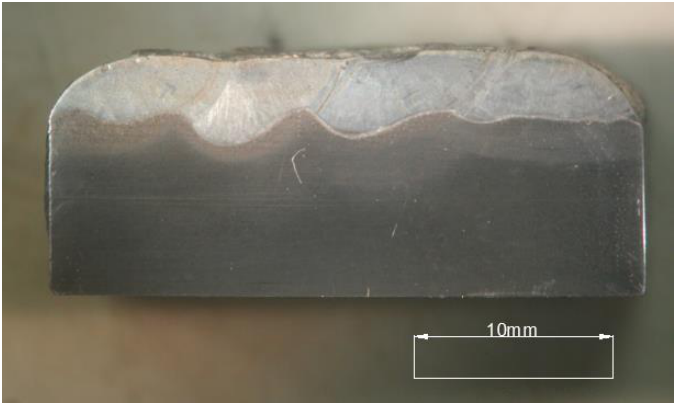
Figure 1. Macrostructure of the cross-section of a nanocrystalline layer, the average width of the overlay layer is 3 mm.